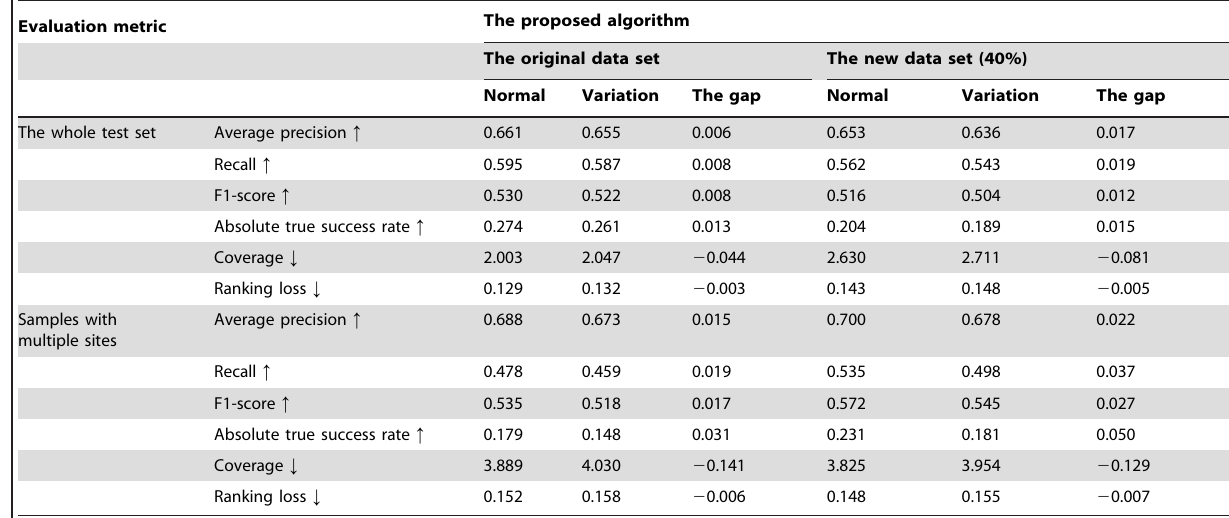
Table 1. The experimental results (mean) on human protein data sets for investigating the usefulness of the correlations among the